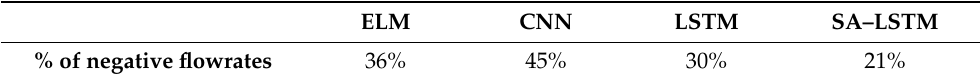
Table 4. Summary of the percentage of negative flowrate estimations by each model during the testing